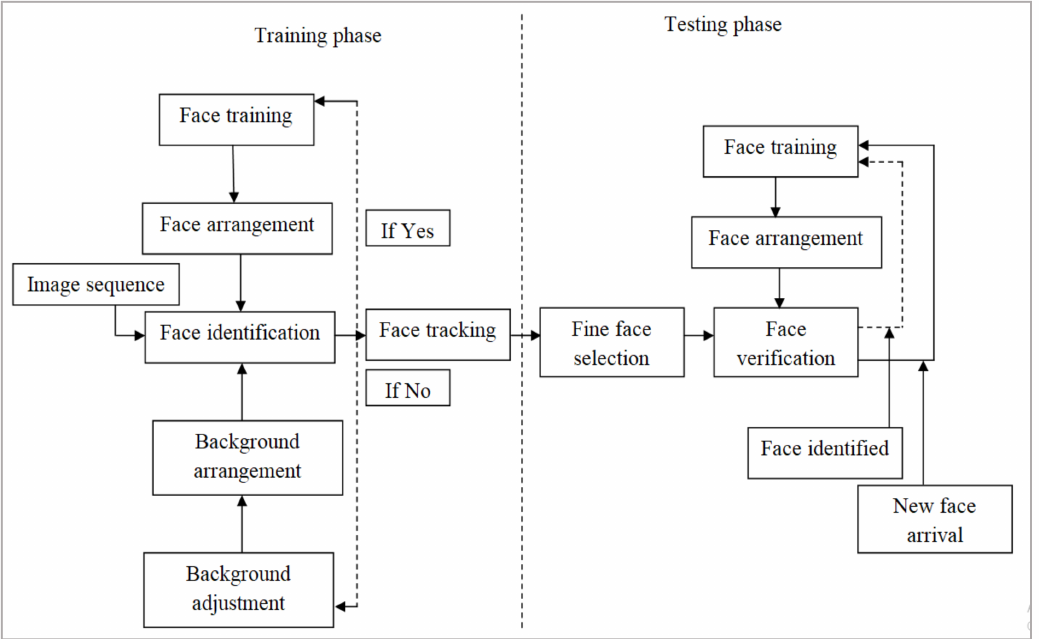
Figure 10. Proposed model for face identification and verification with training and testing stage.